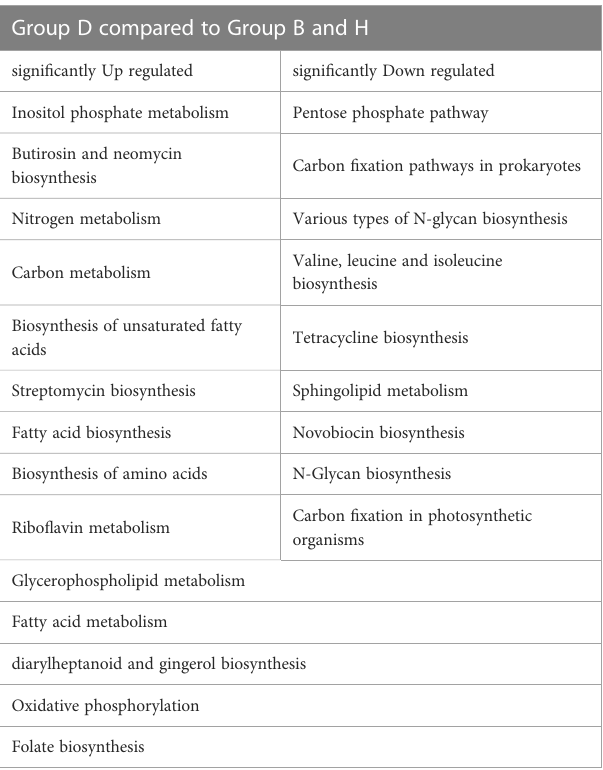
TABLE 1 KEGG terms signi fi cantly changed in the Disease